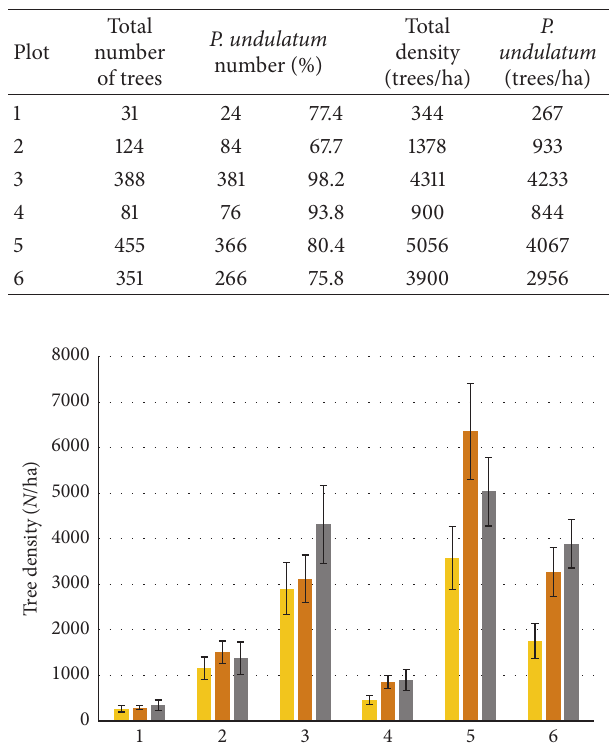
Table 3: Calculation of tree density at six Pittosporum undulatum